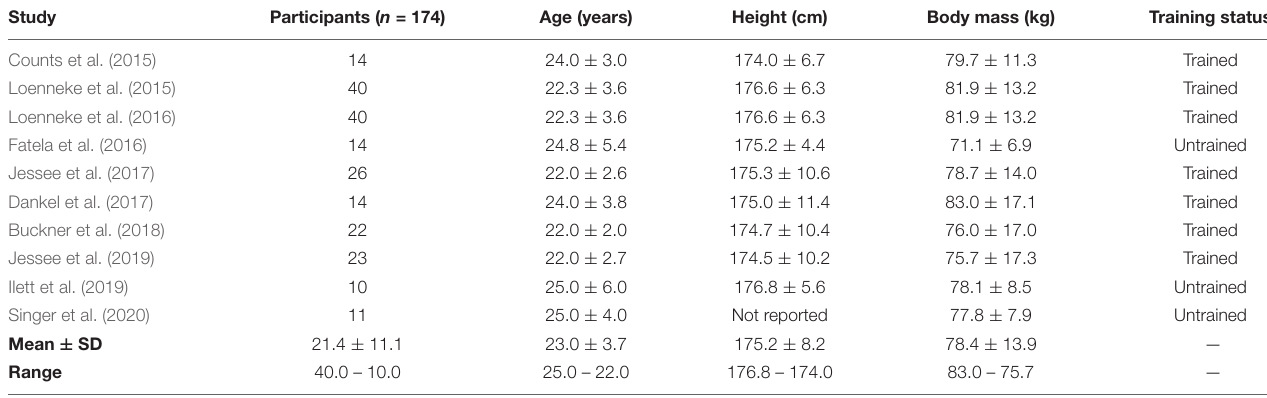
TABLE 2 | Characteristics of the